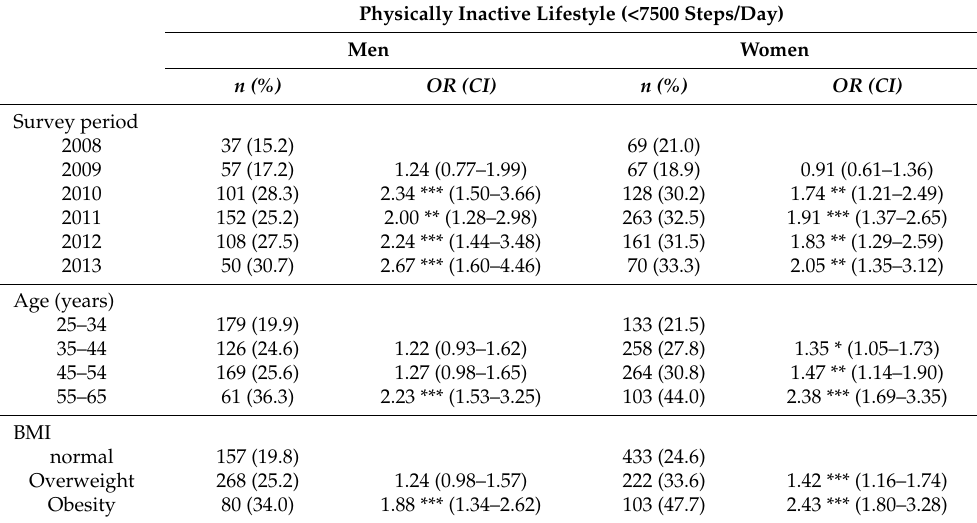
Table 3. Association between a physically inactive lifestyle (<7500 steps/day) and age, body mass index (BMI), and year of monitoring. Physically Inactive Lifestyle (<7500